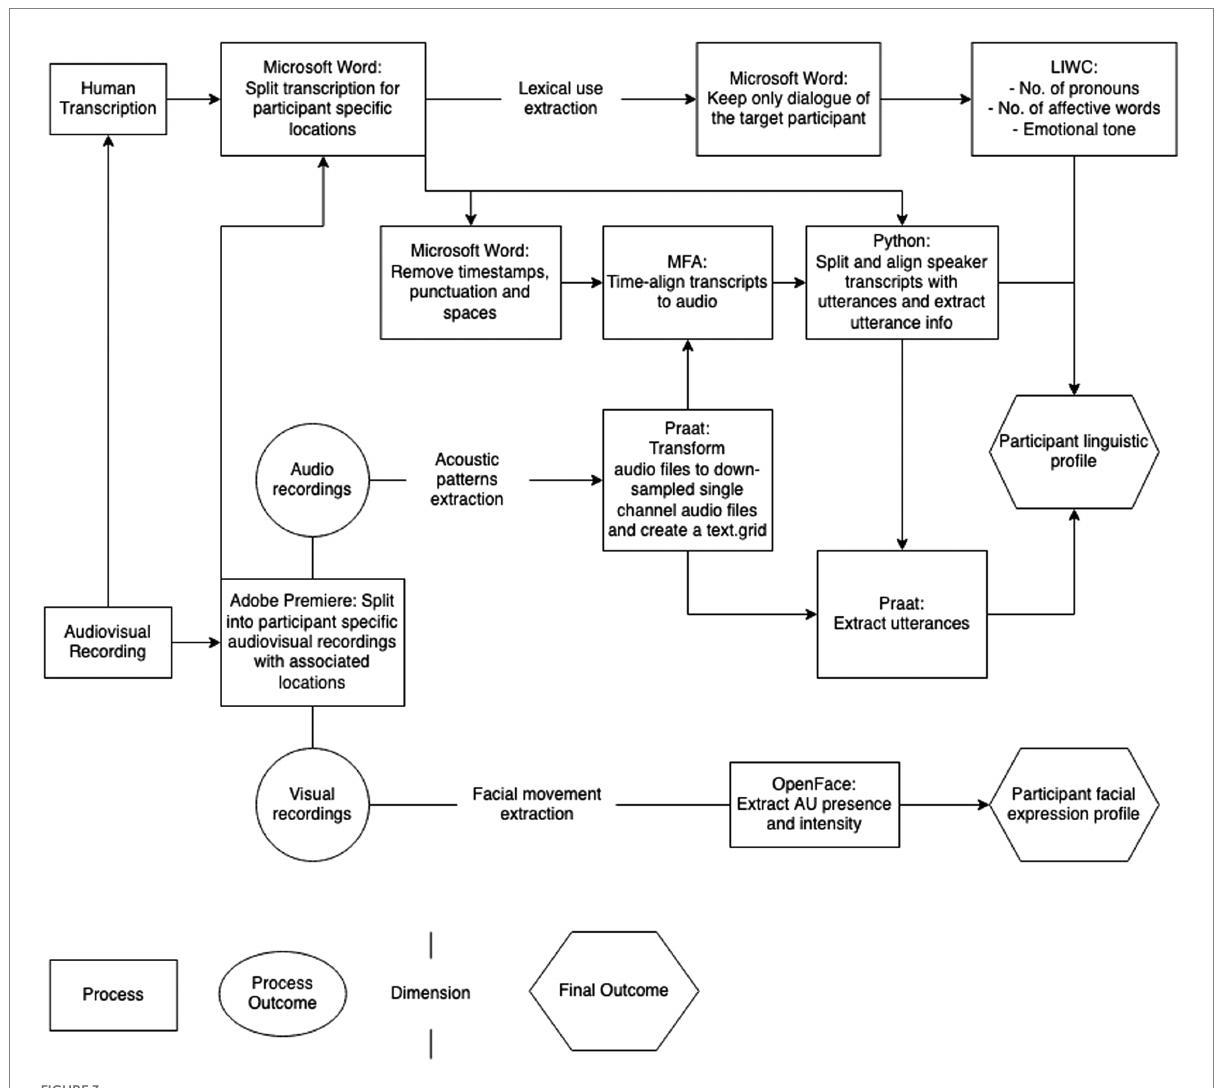
FIGURE 3 Multidimensional analysis workflow from audio-visual recordings. LIWC = Linguistic Inquiry and Word Count; MFA = Montreal Forced Aligner; AU = action unit.